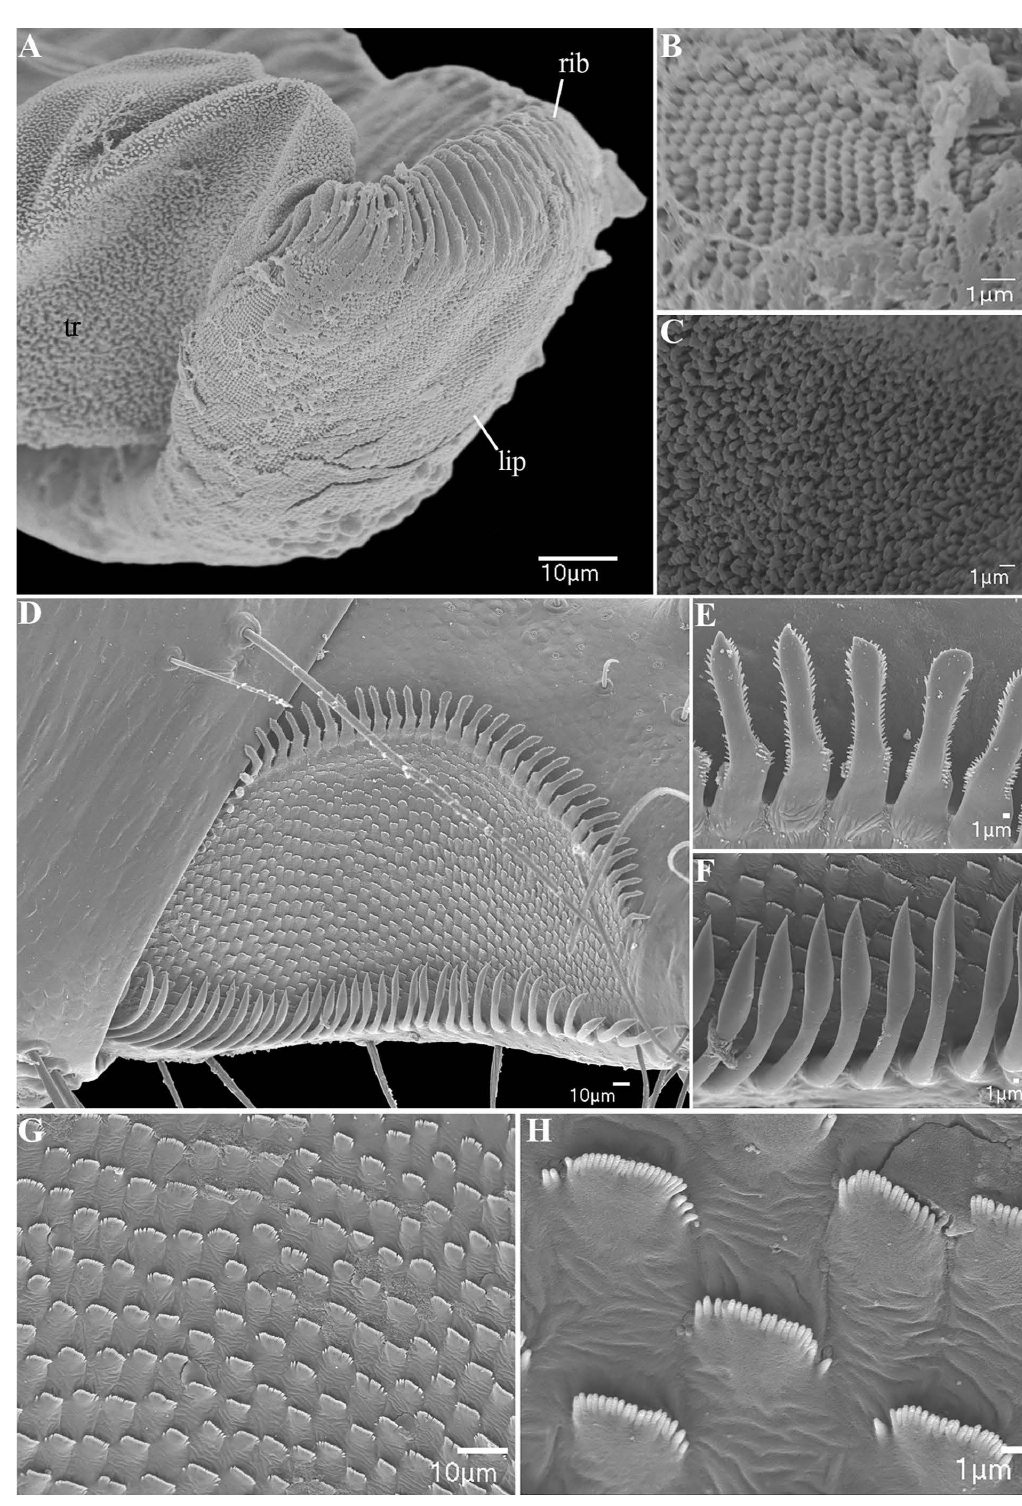
Fig. 87. Charinus africanus Hansen, 1921 (AMCC [LP 6943]), leg IV arolium and pedipalp cleaning brush, ♀. A . Truncus, lip and ribs of arolium, lateral view. B . Aroliar truncus. C . Aroliar lip. D . Cleaning brush of pedipalp tarsus. E . Dorsal row of setae. F . Ventral row of setae. G . Surface between setal rows. H . Small projections on surface between setal rows of cleaning brush on pedipalp tarsus. Abbreviations: lip = distal aroliar lip; rib = ribs of aroliar lip; tr